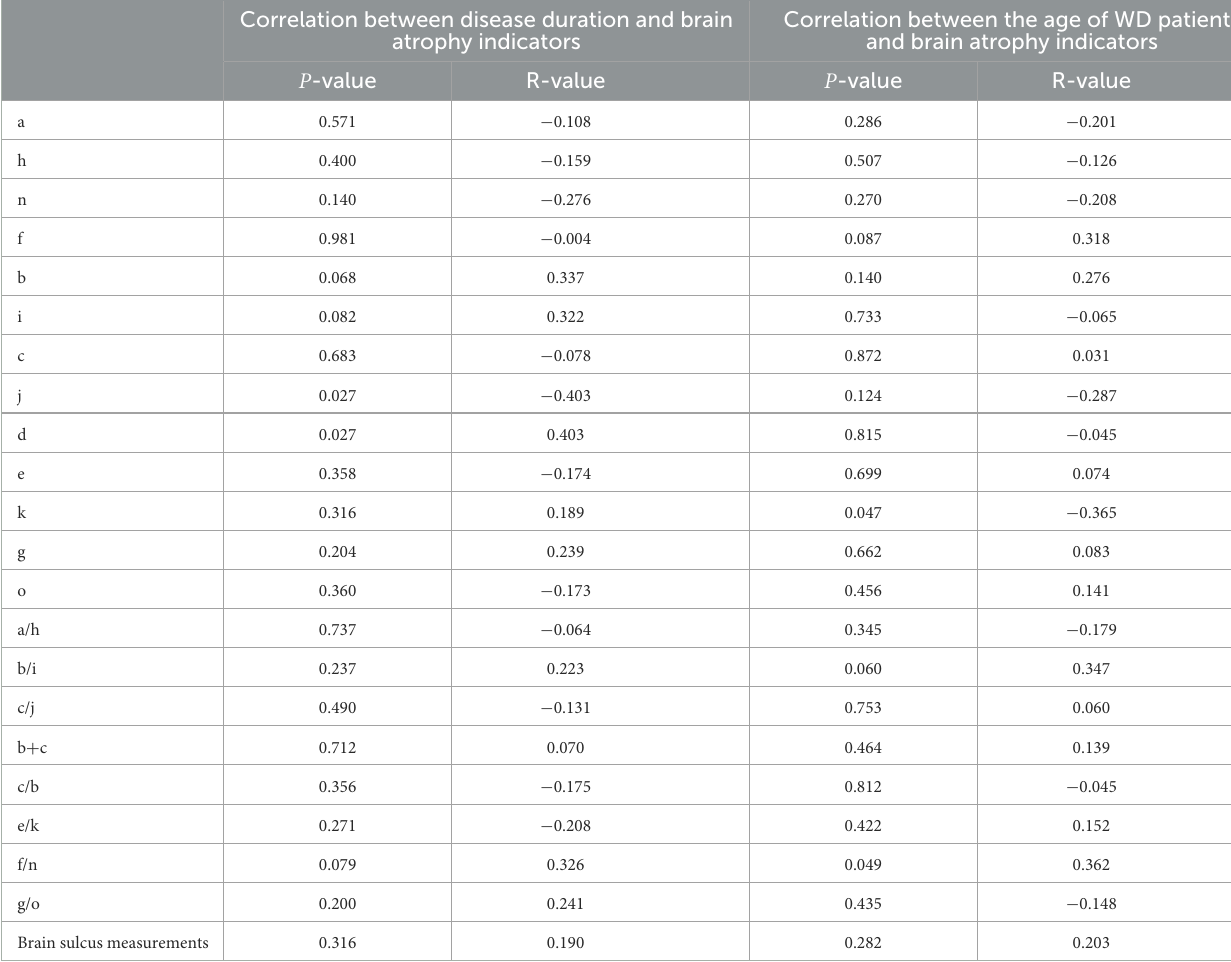
TABLE 3 Correlation between age, disease duration, and linear measurement indicators of brain atrophy in WD patients. Correlation between disease duration and brain Correlation between the age of WD patients atrophy indicators and brain atrophy indicators P -value